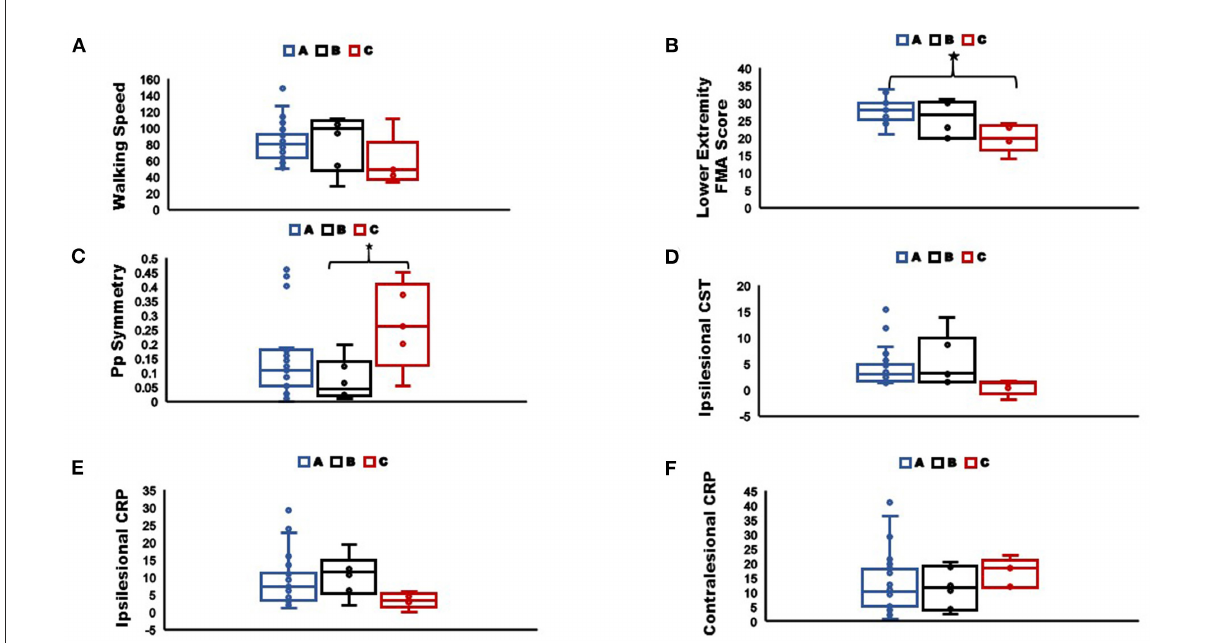
FIGURE7 Comparisons of (A) Walking speed; (B) Lower extremity Fugl-Meyer score; (C) Pp symmetry; (D) Ipsilesional CST streamlines; (E) Ipsilesional CRP streamlines; (F) Contralesional CRP streamlines, between sub-groups as classified by the classification tree (*indicate significant difference between groups at p < 0.05). The box plots indicate the range in the data, horizontal line in the center is the median, the upper and lower boundaries of the box indicate the upper and lower quartile respectively, and markers represent the extreme values. Group A: correctly classified individuals with more than two modules, Group B: incorrectly classified individuals with two modules, Group C: correctly classified individuals with two